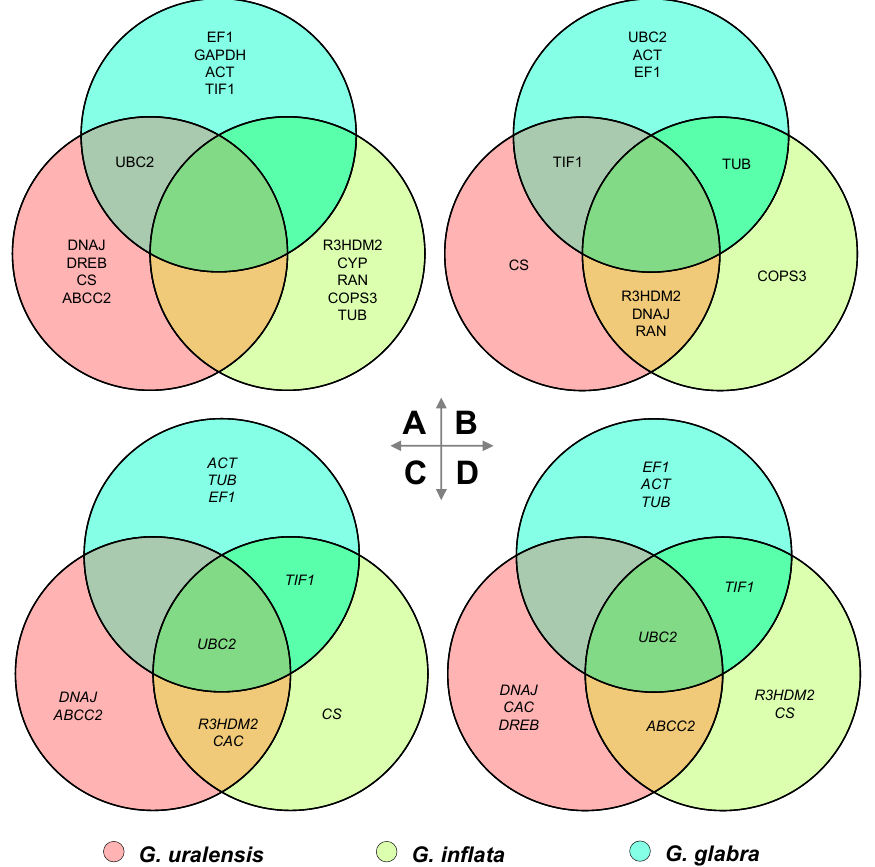
Figure 5. Comparison of the recommended reference genes among three Glycyrrhiza species: the Venn diagram compares the top five most suited reference genes recommended for the leaf ( A , B ) or root ( C , D ) under control or osmotic stress conditions, respectively, among the three congeneric species.